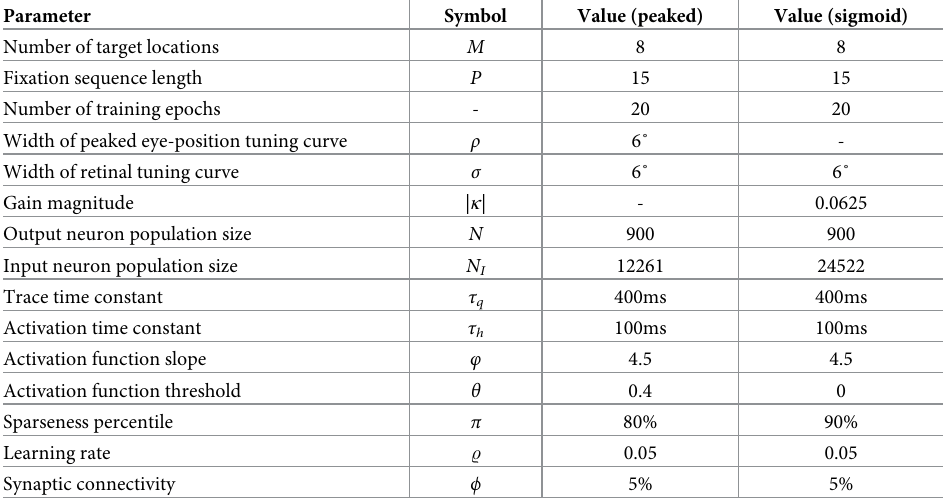
Table 1. Simulation parameter of self-organising models with either peaked or sigmoidal eye-position gain